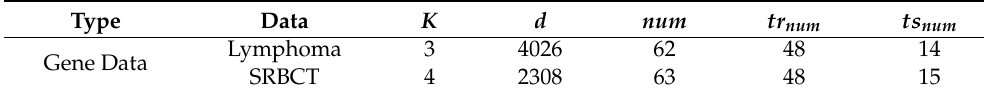
Table 3. Genedata structures: data dimension ( d ), number of data ( num ), number of training data ( tr num ), number of testing data ( ts num ), number of classes ( K